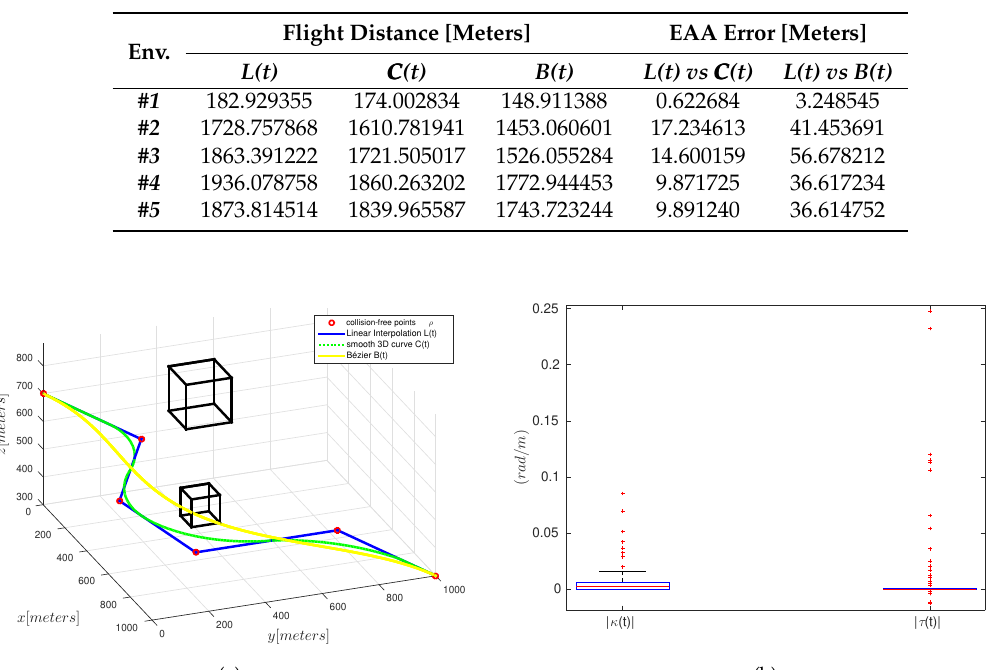
Table 2. Flight distance of the curves. The column "Flight distance (meters)" shows the distance in meters at the initial and final free collision points marked by ρ . The column "EAA Error (meters)" shows the average error in meters along the trajectories.